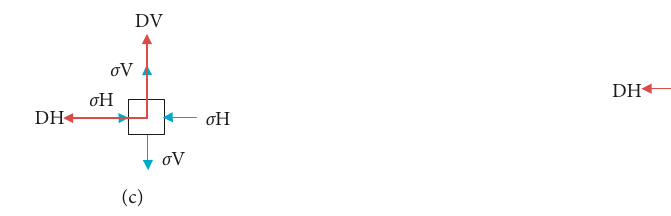
Figure 18: Stress and displacement of roadway floor measuring points when the cumulative duration is 539–550mins; (a) monitoring curve of F01, F02, and F03; (b–d) schematic diagram of F01, F02, and F03, respectively.